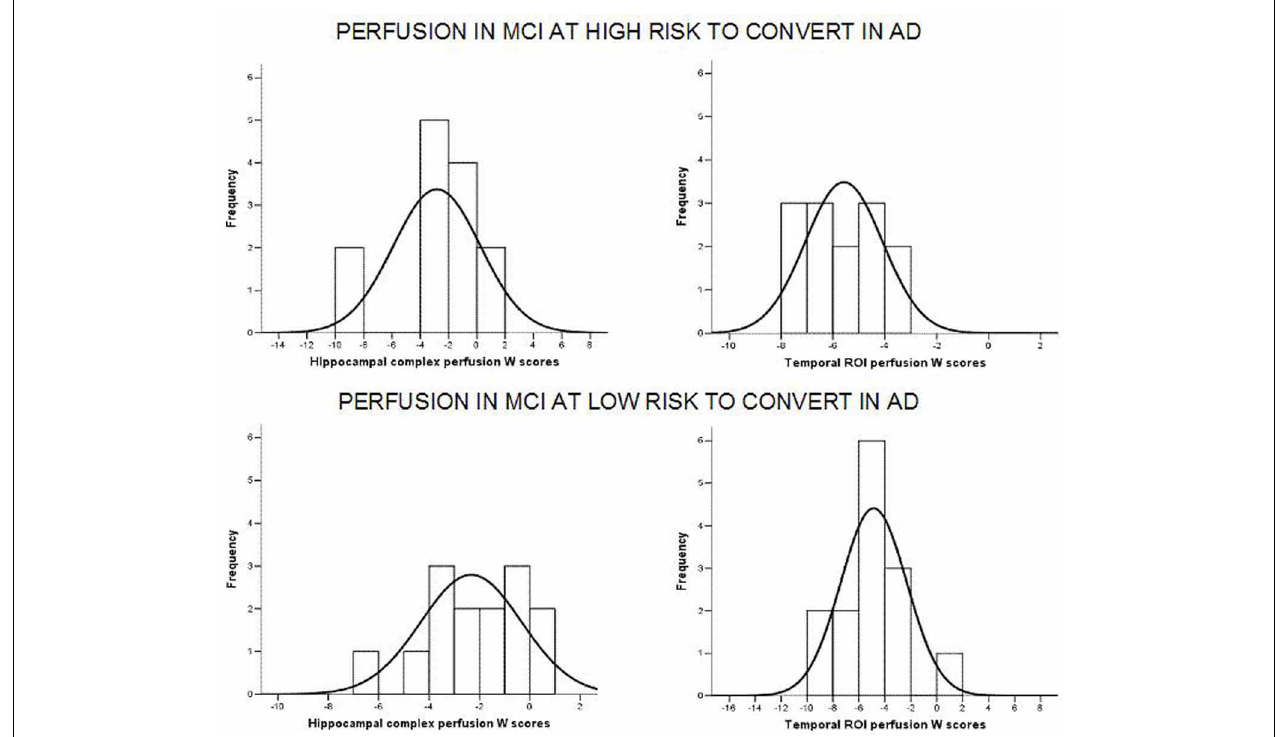
FIGURE 2 | Histograms of the perfusion W scores distribution in at low and at high risk patients for hippocampal complex (left column) and temporal (right column) ROIs. Generally, for at high risk MCIs, perfusion scores are attested